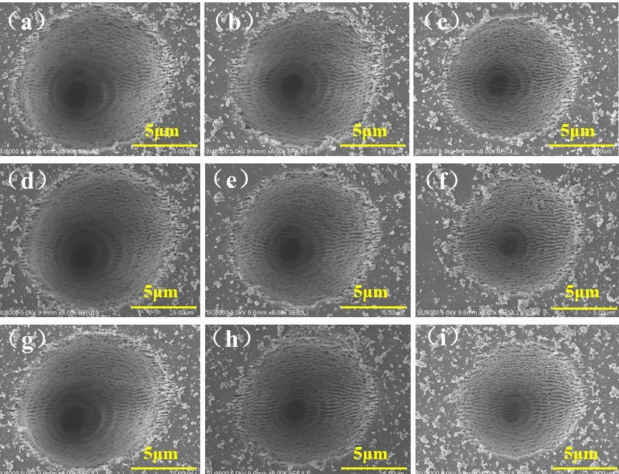
Figure 2. The surface morphology of microholes was ablated by Gaussian beam with different single pulse energy and pulse numbers. ( a ) The microholes were ablated with Gaussian beam at 4 µ J, and pulse number were 1 × 10 6 ; ( b ) The microholes were ablated with Gaussian beam at 4 µ J, and pulse number were 1 × 10 5 ; ( c ) The microholes were ablated with Gaussian beam at 4 µ J, and pulse number were 1 × 10 4 ; ( d ) The microholes were ablated with Gaussian beam at 3 µ J, and pulse number were 1 × 10 6 ; ( e ) The microholes were ablated with Gaussian beam at 3 µ J, and pulse number were 1 × 10 5 ; ( f ) The microholes were ablated with Gaussian beam at 3 µ J, and pulse number were 1 × 10 4 ; ( g ) The microholes were ablated with Gaussian beam at 2 µ J, and pulse number were 1 × 10 6 ; ( h ) The microholes were ablated with Gaussian beam at 2 µ J, and pulse number were 1 × 10 5 ; ( i ) The microholes were ablated with Gaussian beam at 2 µ J, and pulse number were 1 × 10 4